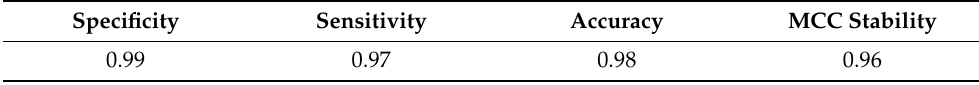
Table 3. Mean scores for 10-fold cross-validation